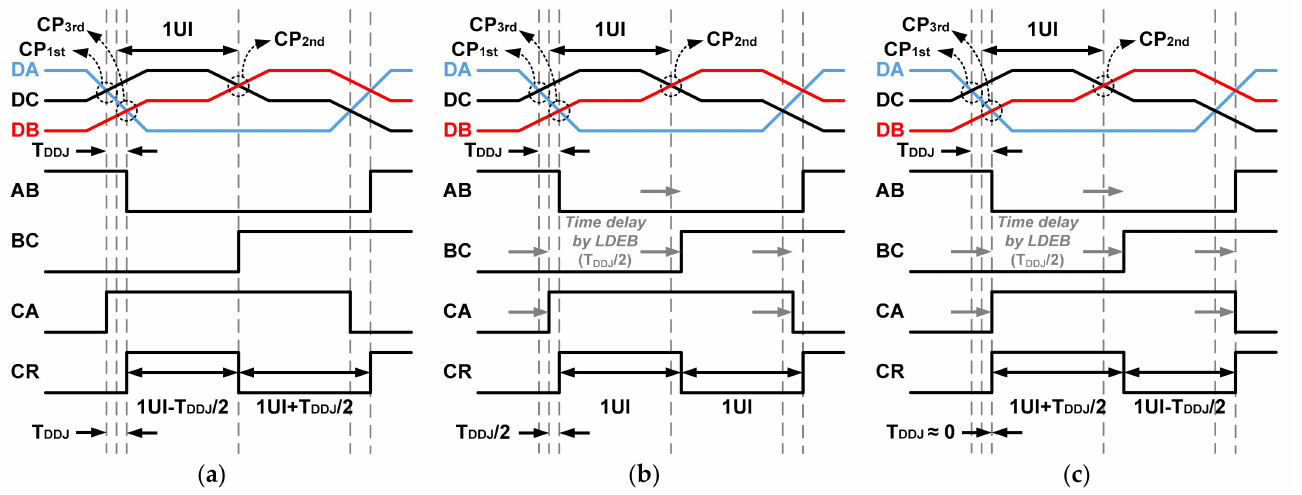
Figure 4. Time jitter of data and clock according to proposed pre-determined data pattern: ( a ) without LDEB; ( b ) with optimal LDEB; ( c ) with excessive